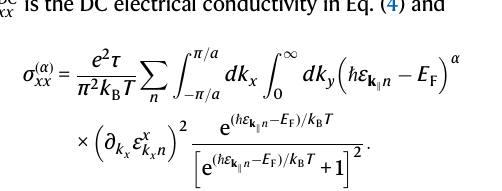
conductivities for b / a =0.5 and different values of V 0 = E 0 F , normalized to the respective 2DEG conductivity at T =200 K. Temperature dependence of the ratiobetweenthermalandelectricconductivities,revealingdeviationsfrom the Wiedemann – Franz law for b / a =0.5 and various values of the ratio V 0 = E 0 F ( e ), as well asfor fi xed V 0 = E 0 F =5and several values of b / a ( f ).We use thesame material parameters as in Fig.